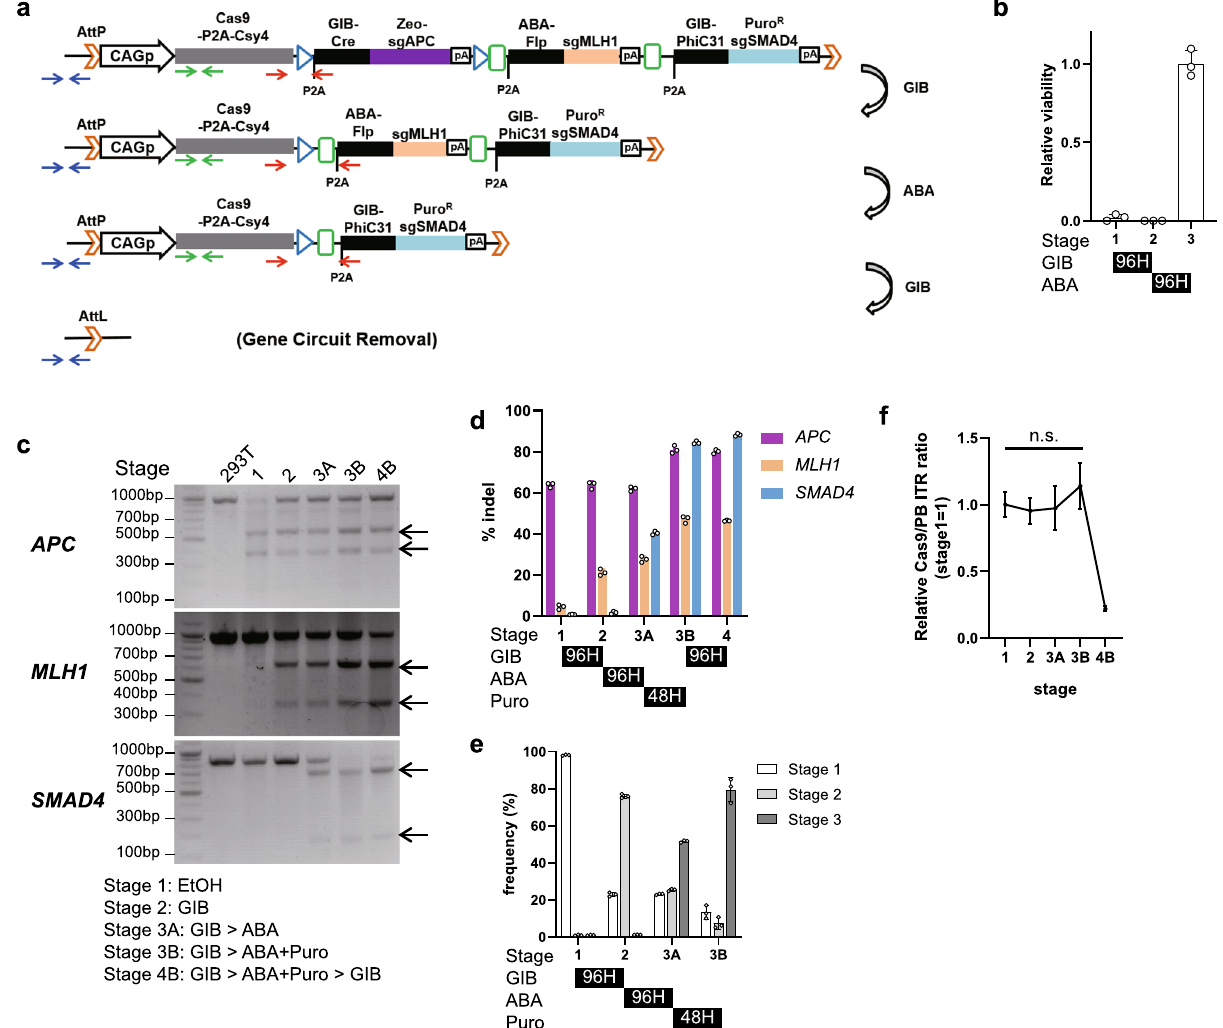
Fig. 4 Sequential actuation, synchronization, and gene circuit removal by AttP-tandem GPCv2-CRISPR. a AttP-tandem GPCv2-CRISPR schematics. Red arrows indicate primers used for amplifying the scar sequence to identify the stage within the cascade, used in e . Blue and green arrows indicate primers used for assessing gene circuit removal in f . Red arrows indicate primers used for amplifying scar sequence quantifed in e . b Relative viability of cells under puromycin selection at speci fi c stages in the cascade ( n = 3, mean±s.d.). Data are normalized to the viability at stage 3. c Validation of sequential gene mutations using T7 endonuclease assay. Arrows indicate cleaved bands. The expected lengths of uncleaved and cleaved bands are the same as those in Fig. 3e. d Quanti fi cation of gene editing in c by NGS ( n = 3, mean±s.d.). e NGS quanti fi cation of frequency scar sequences that corresponds to each stage in the cascade ( n = 3,